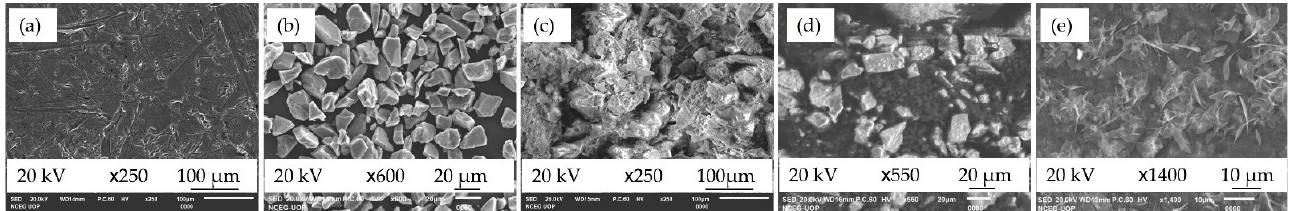
Figure 2. SEM of the raw materials ( a ) AA7075 (as received), ( b ) Silicon Carbide, ( c ) Rice Husk Ash, ( d ) Carbonized Eggshell and ( e ) Mg Ribbon.